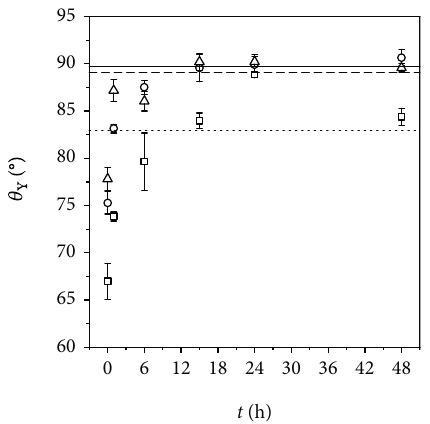
Figure 7: Results of the water contact angle measurements θ function of the time spent in vacuum after cleaning: CCC (triangle), AAA (square), and NC (circle). The lines are the mean contact angles averaged over the results reported in Table 1 for each cleaning agent: CCC (solid), AAA (dotted), and NC